Question: What visual encoding does this figure use to show its data?
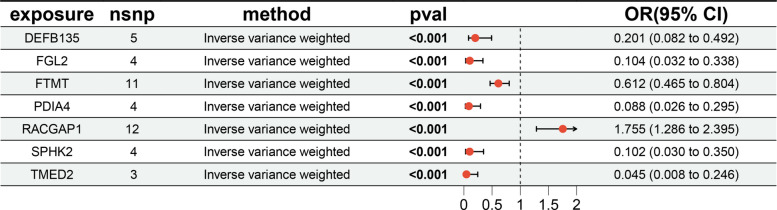
Answer: forest